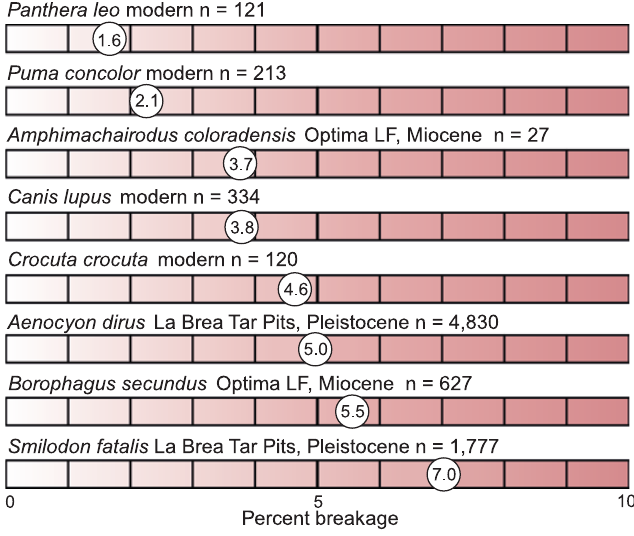
Fig. 6. Tooth breakage percentages for Optima Local Fauna (Miocene, late Hemphillian, Oklahoma, USA), Pleistocene, and modern felids and canids. Higher percent tooth breakage corresponds with darker shade. Pleistocene and modern data from Van Valkenburgh